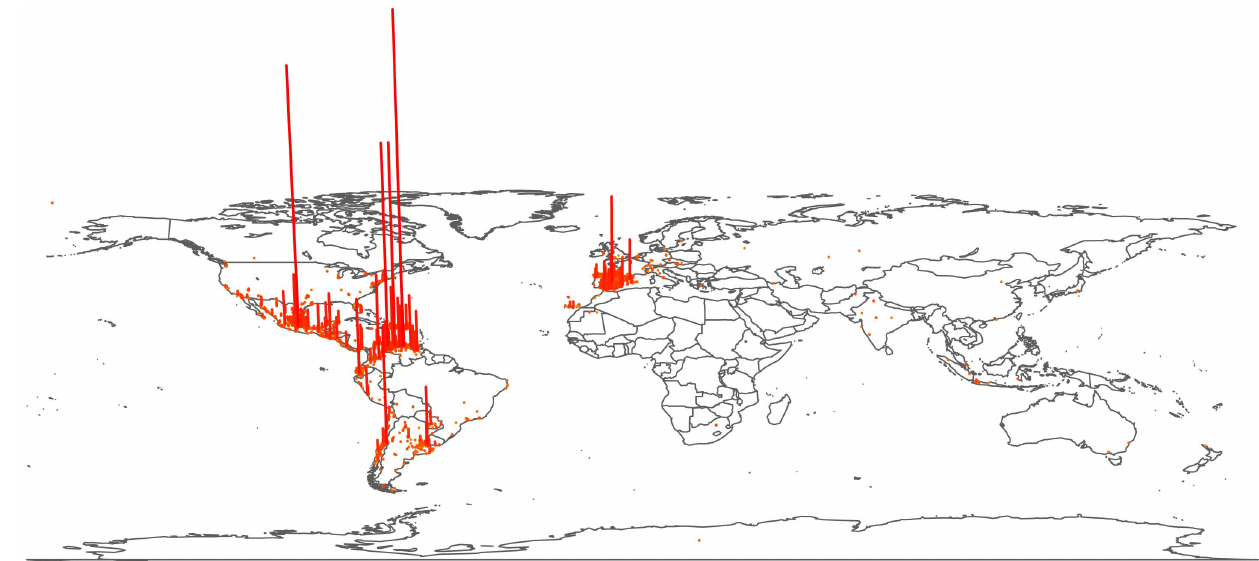
Figure 1. Spanish tweet locations. The overwhelming majority of Spanish tweets are located in Spain and Spanish America but significant contributions arise in certain US states and major Western European and Brazilian cities.